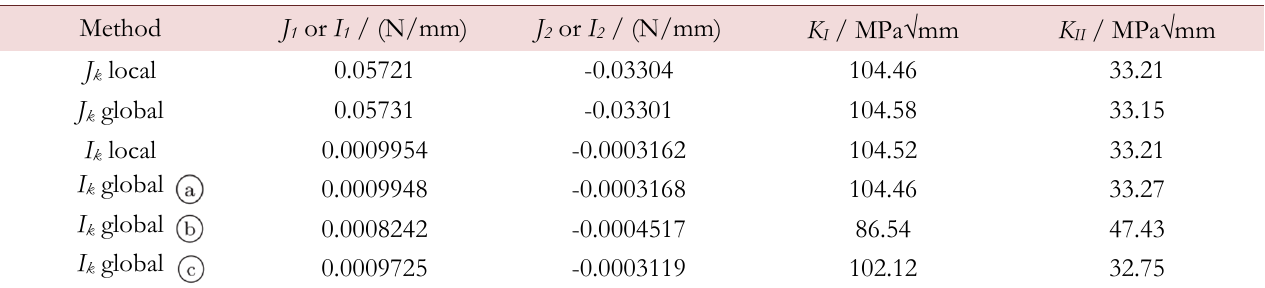
Table 1: Numerical values of local and global J k - and I k -integrals and SIF, three different choices of the auxiliary fields a – c . From the results in Tab. 1 it is obvious that path-independence is only retained considering interface